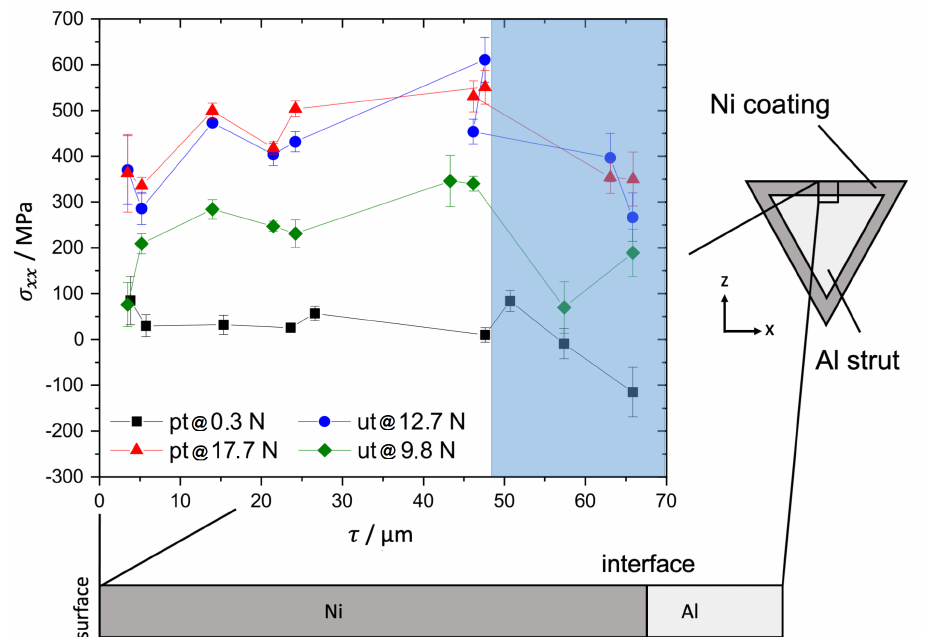
Figure 7. Depth distribution of the in-plane stress σ xx perpendicular to the bending axis measured by the depth-resolved technique: The untreated (ut) and the pre-treated specimen (pt) show a reduced in-plane stress perpendicular to the bending axis near the interface. Therefore, in case of zero applied stress, small compression residual stresses are present near the interface. The depth region of reduced local stress is marked in blue.